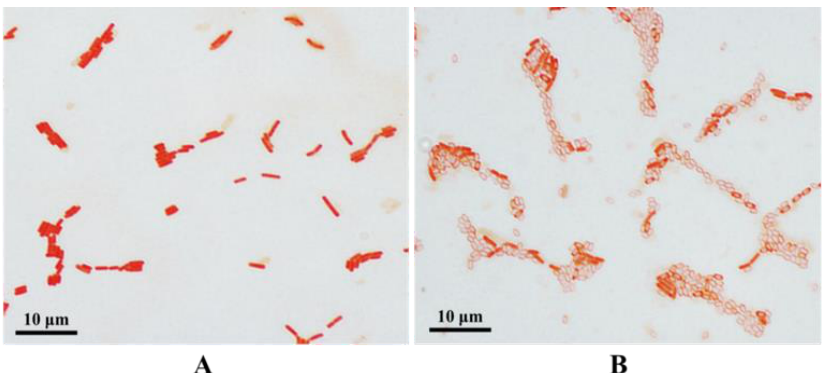
Figure 1. The colony morphology of WTC016.